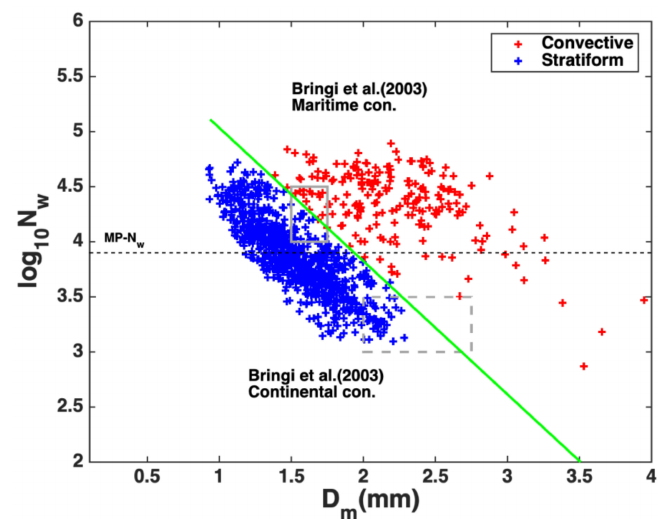
Figure 6. Scatter plot of D m and log 10 N w for convective (red cross) and stratiform (blue cross) rain types. The two gray rectangles represent the maritime (solid line) and continental convective (dashed line) clusters by Bringi et al. (2003). The green line represents the separation line and was drawn based on visual examination of the data.